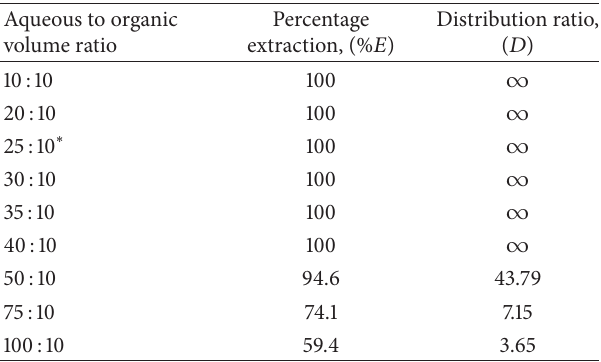
Table 4: Metal loading capacity of n-octylaniline. (pH = 0.50,